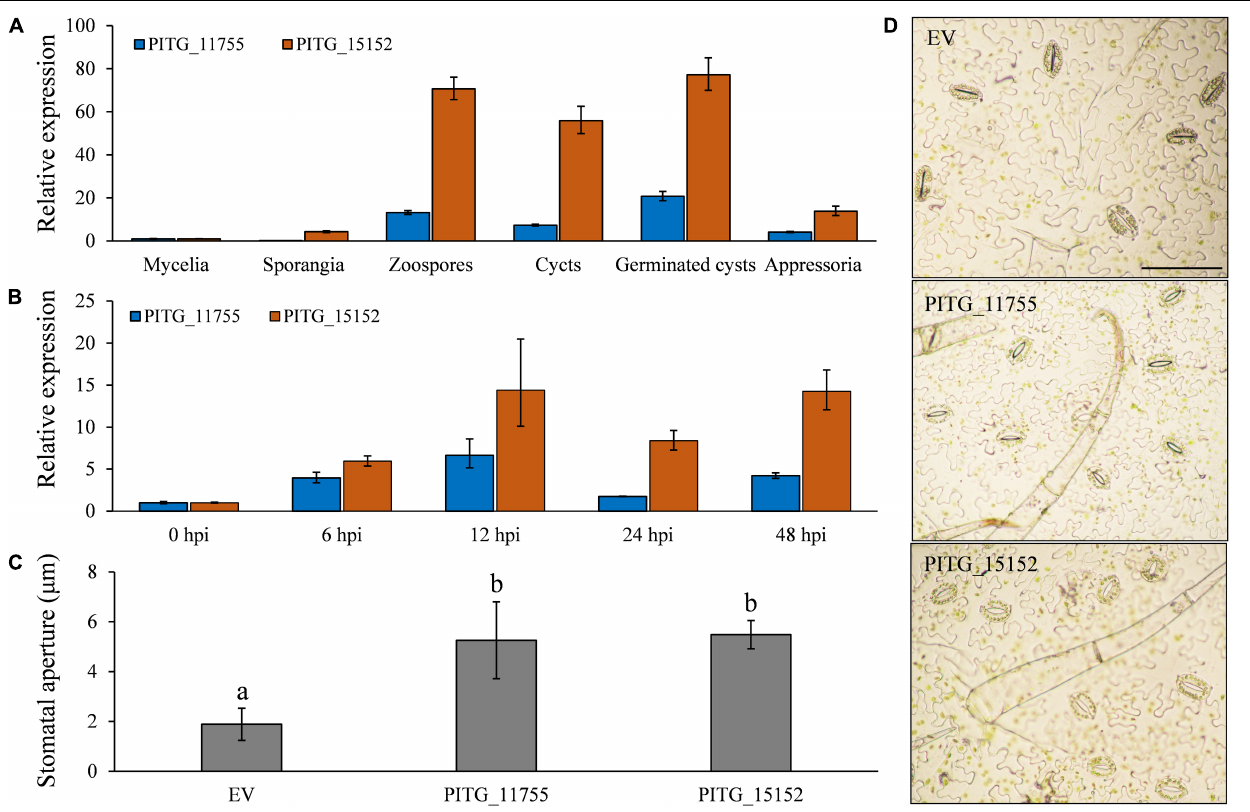
FIGURE 10 | Both extracellular and intracellular effector proteins participate in P. infestans infection-induced stomata opening. (A) The putative effectors PITG_11755 and PITG_15152 were highly expressed during pre-infection development and (B) at both early and late time points in planta ; (C) the overexpression of PITG_11755 and PITG_15152 significantly increased the stomatal aperture; and (D) images show increased stomatal apertures after effector overexpression. Photos within a panel are from a representative of a single replicate while photos among panels are pooled from multiple